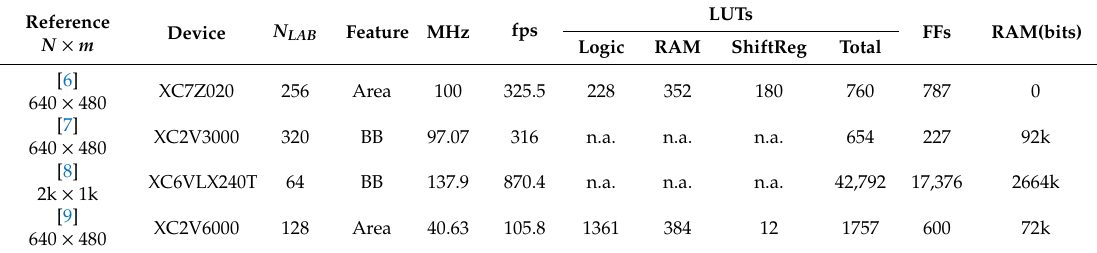
Table 4. Characteristics of state-of-the-art one-scan